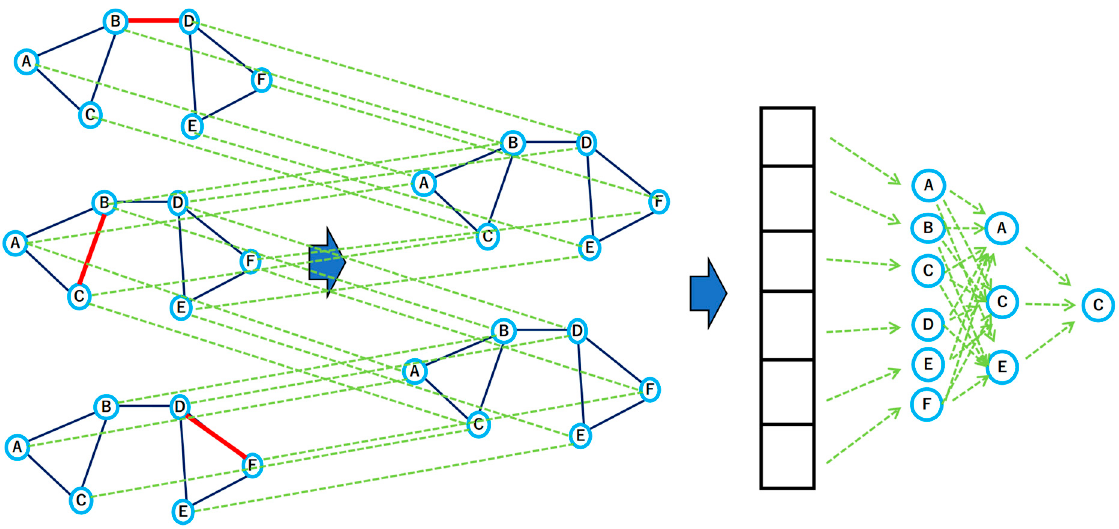
Figure 3. Illustration of a GCN. A single-node aggregate messages from its local neighborhood, and these messages are based on the information from their respective neighborhoods. Red line is featured edge, and is the start point. Six-block-diagram represents pooling ( 2020 , arXiv:2011.14365v1. [88]).